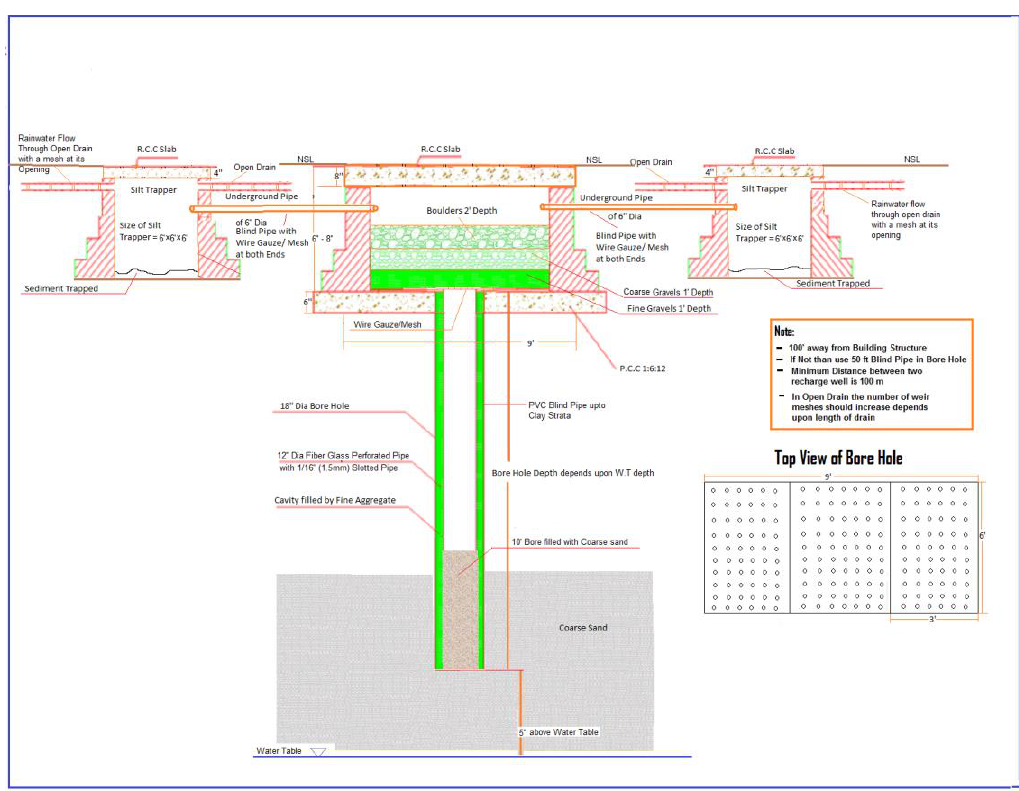
Figure 14. Typical design of a recharge well used for rainwater harvesting (RWH) in Gaddafi Stadium.